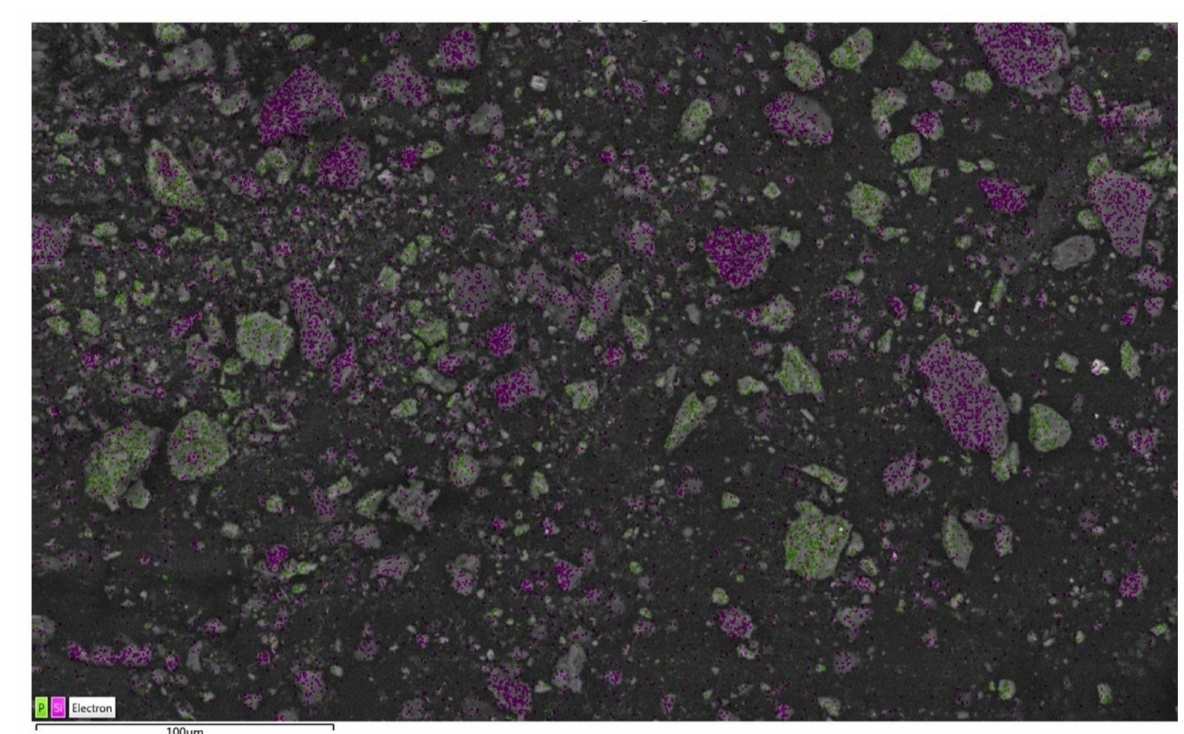
Figure 16. SEM_EDS surface distribution of phosphorus and silicon in silicon tailings after